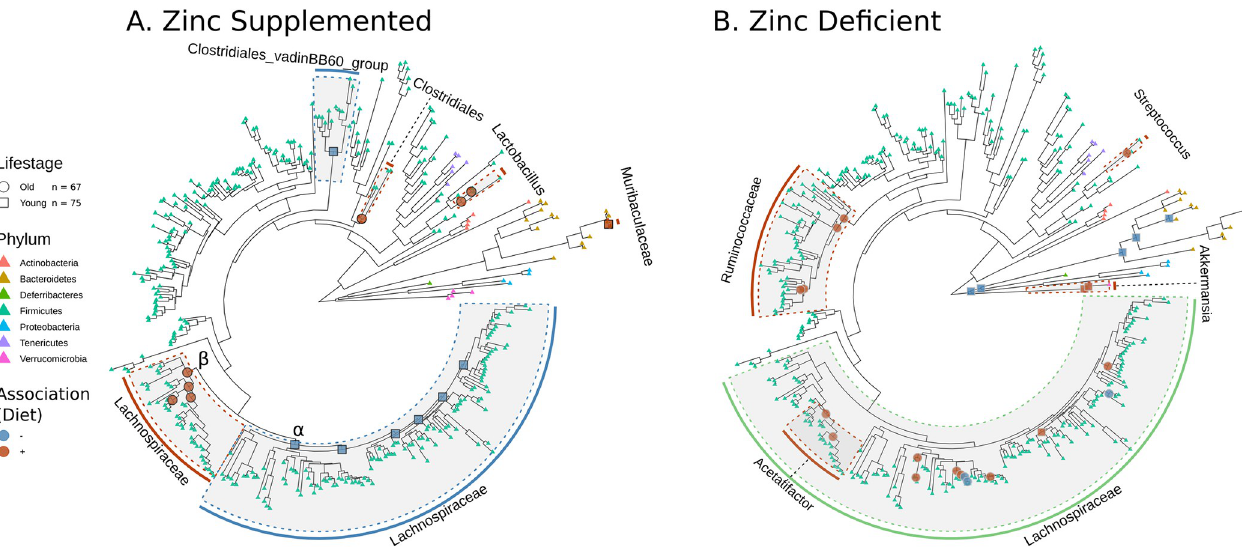
Fig 3. Associations between bacterial cladal abundance and dietary zinc supplementation and deficiency. The phylogenetic tree (identical for both A and B) is based on alignment of ASVs to a reference 16S alignment. Clades are marked with host lifestage (circles for old and squares for young mice, respectively) and type of association (blue for negative, orange for positive) with dietary zinc supplementation (A) and deficiency (B). Shaded clades are marked with the respective shared taxonomic phylotype, and color coded based on association (green indicates variable association within a particular clade). Tree tips are colored based on taxonomic phylum, regardless of dietary zinc status. α and β indicate Lachnospiraceae clades that associate with zinc supplementation in a negative and positive way, respectively. n = 75 young mice fecal samples (37 in supplementation study, 38 in deficiency study), n = 67 old mice fecal samples (32 in supplementation study, 35 in deficiency study), using both week 0 and week 6 fecal samples.